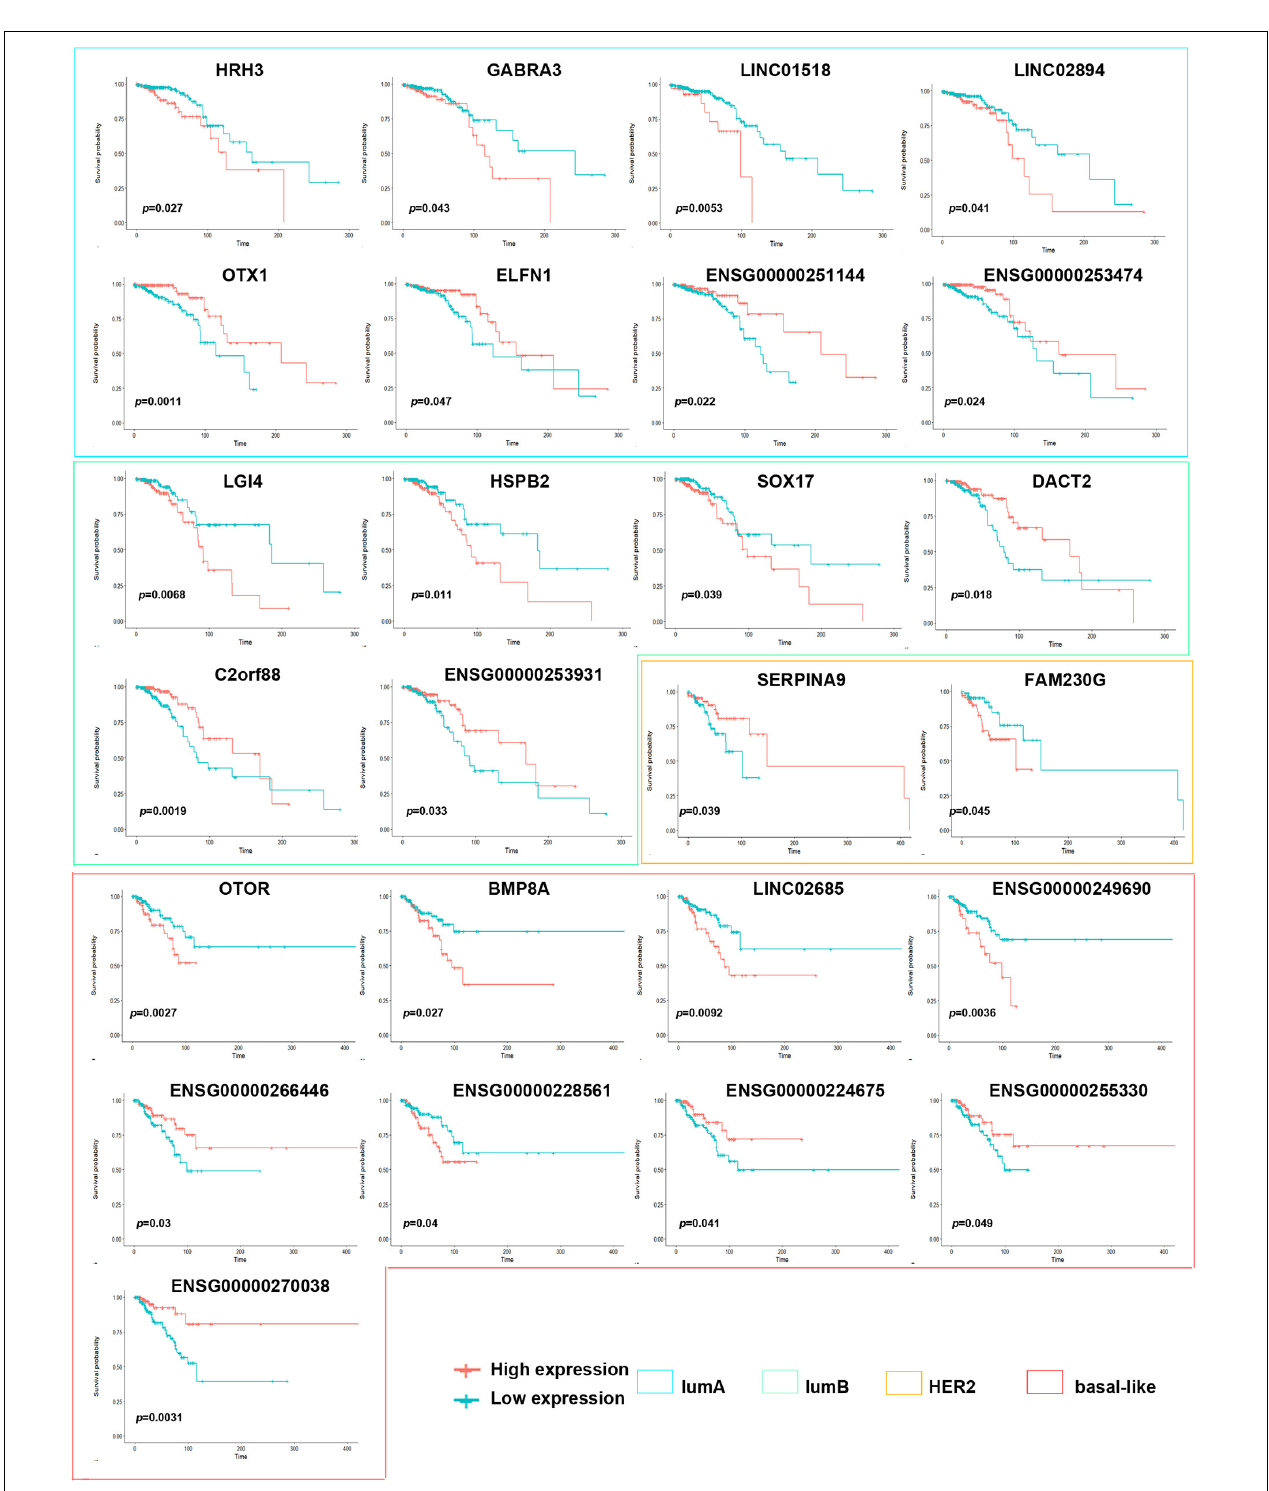
FIGURE 2 | Correlation of expression of subtype-specific RNA with overall survival in breast cancer. Kaplan–Meier survival curves were generated for subtype-specific RNA by comparing groups of high (red line) and low (blue line) gene expression. p < 0.05 in log-rank test.